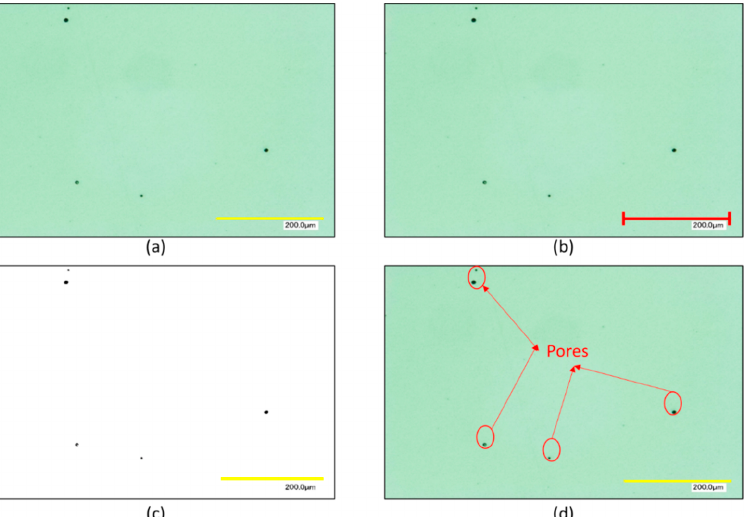
Figure 5. Part Density Measurement methodology ( a ) import microscope image, ( b ) set image scale, ( c ) convert image to binary and ( d ) analyse the pores